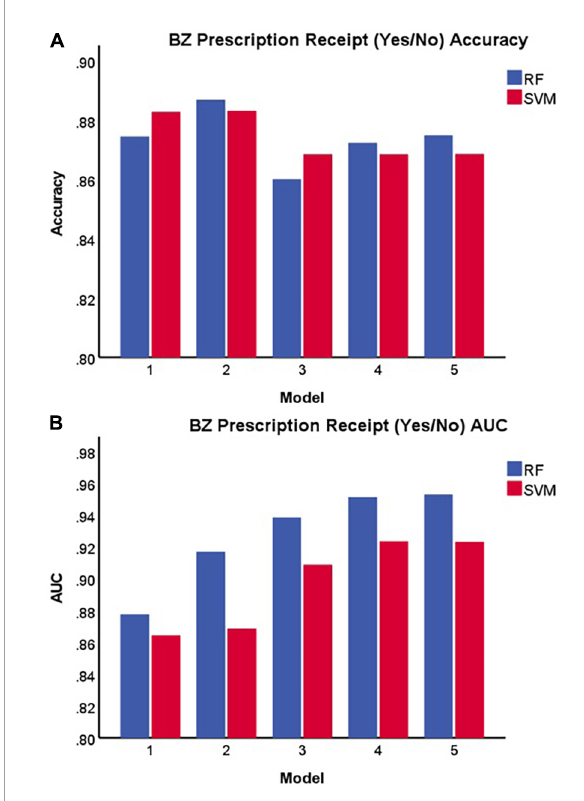
FIGURE2 Accuracy (A) and area under the receiver operating characteristic curve (B) of each model in predicting benzodiazepine prescription receipt at a given encounter (yes/no). BZ, benzodiazepine; SVM, support vector machine; RF, random forest; AUC, area under the receiver operating characteristic curve.